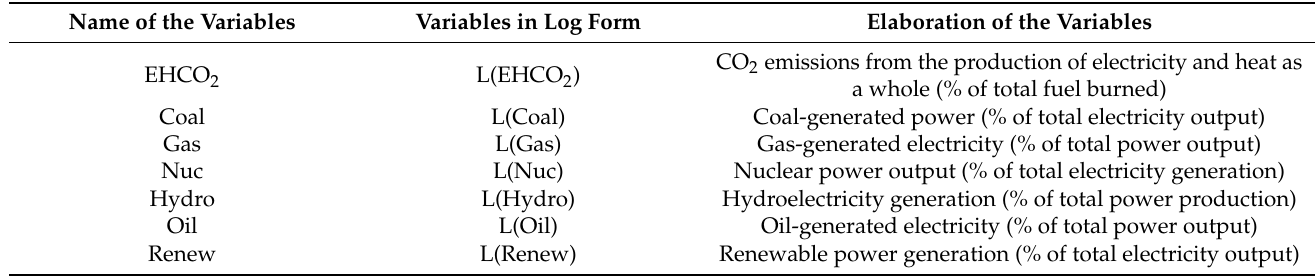
Table 1. Introduction of Selected